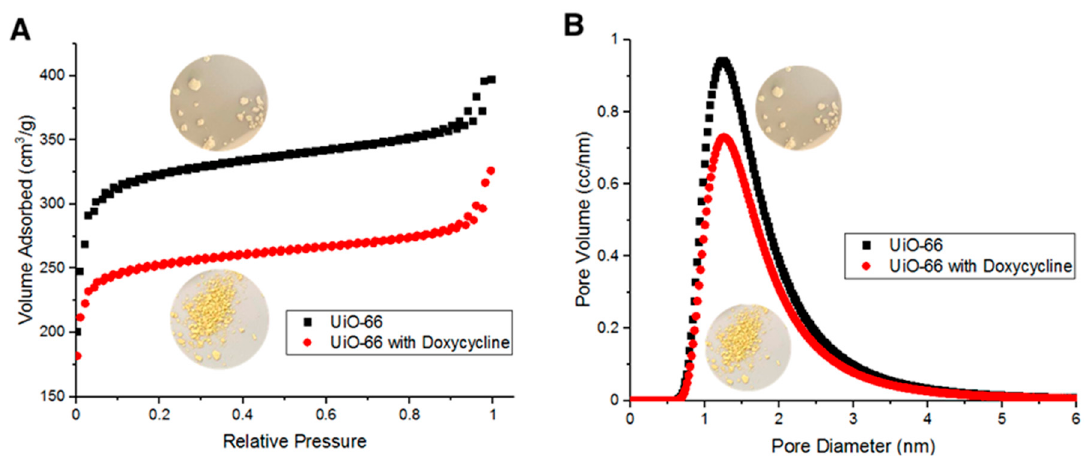
Figure 6. ( A ) Brunauer–Emmet–Teller (BET) adsorption / desorption isotherms for fresh UiO-66 and Doxycycline-filled UiO-66 and ( B ) pore diameter distribution with respect to volume of fresh UiO-66 and Doxycycline-filled UiO-66.